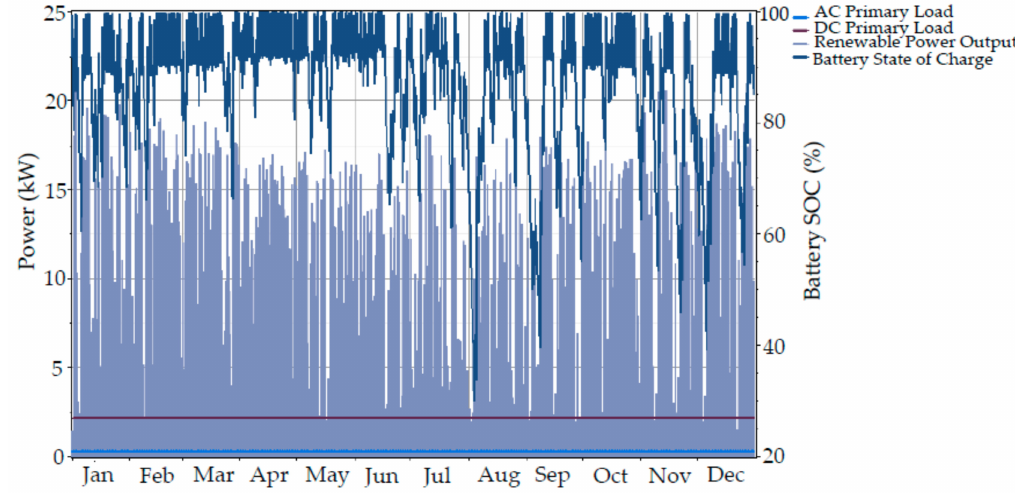
Figure 8. The average hourly power contribution of the PV array and battery